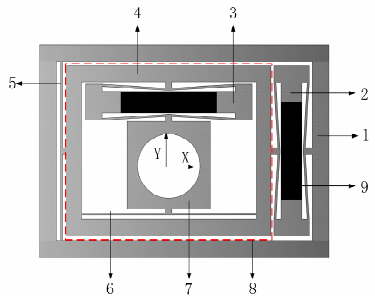
Figure 1. Structure diagram of micro-positioning platform.